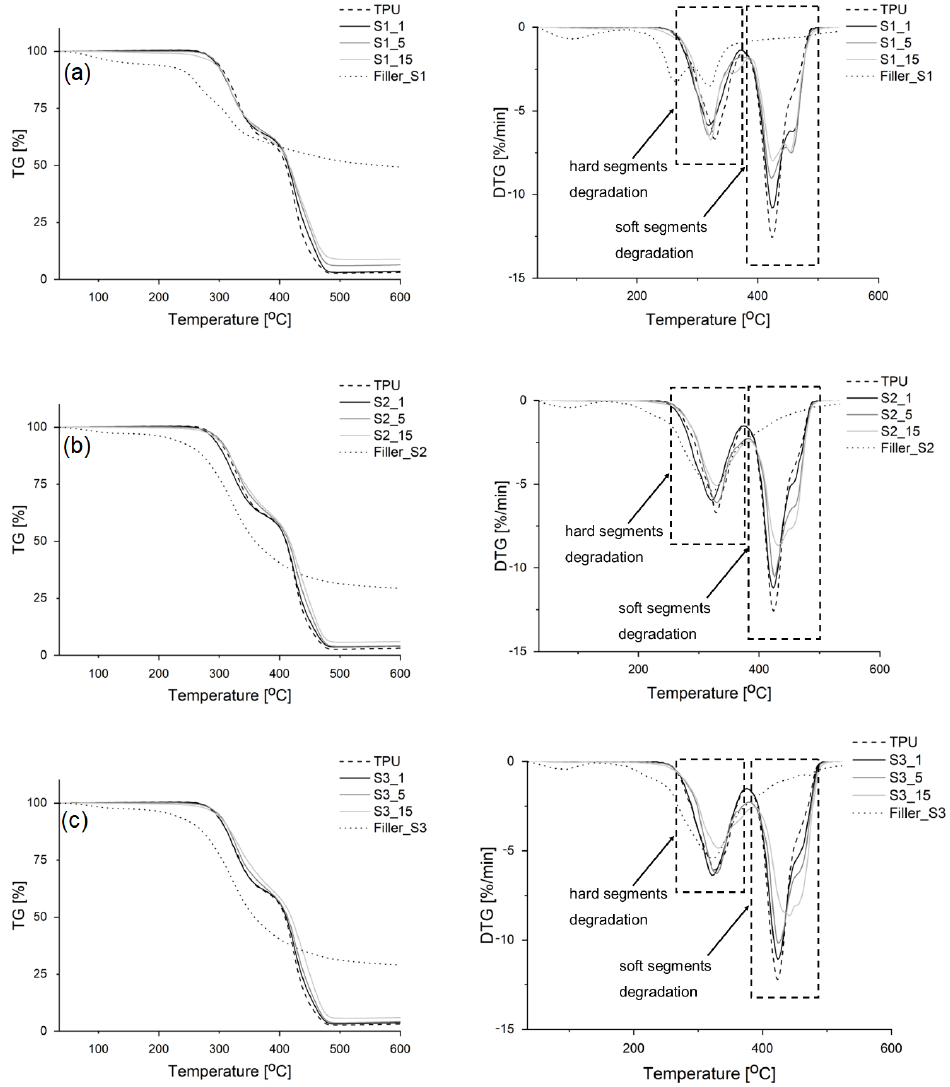
Figure 4. TG and DTG as a function of temperature for bio-TPU-ABW composites: ( a ) S1, ( b ) S2 and ( c ) S3.